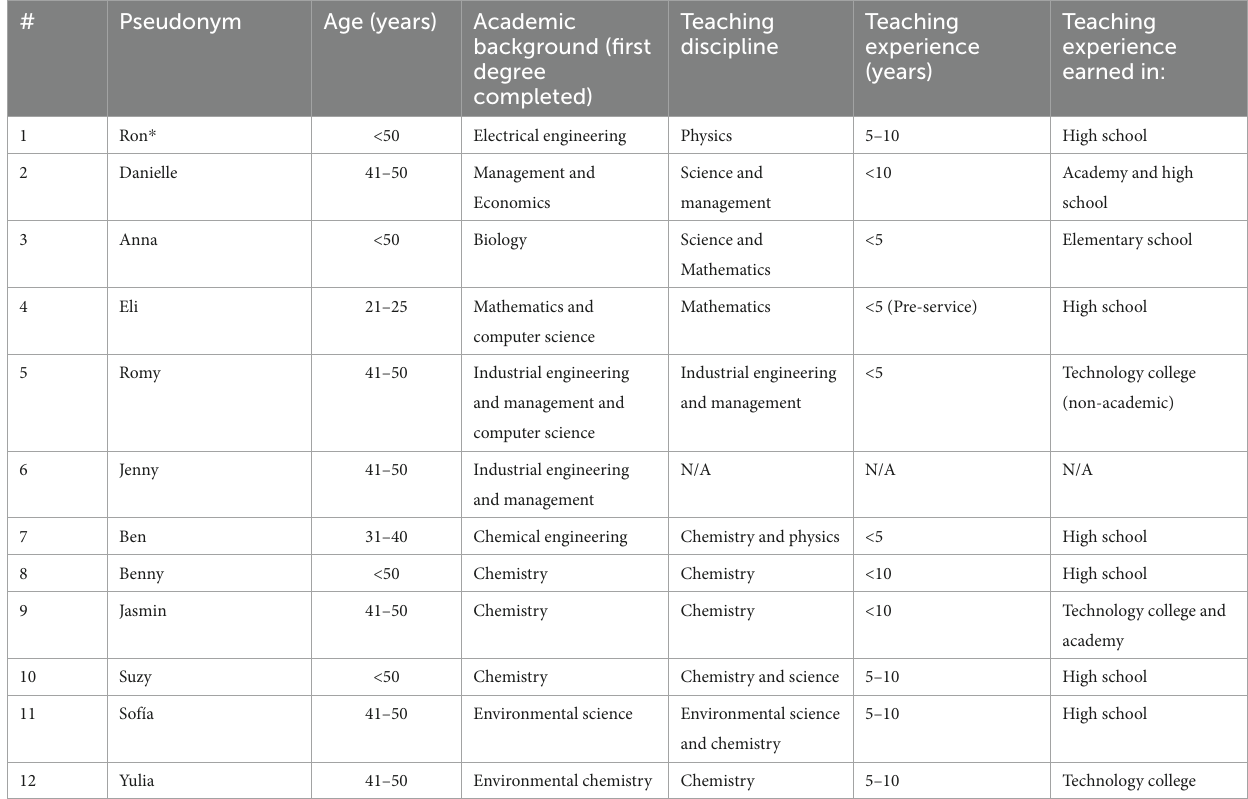
TABLE 2 The background of the 12 participants that made up the initial